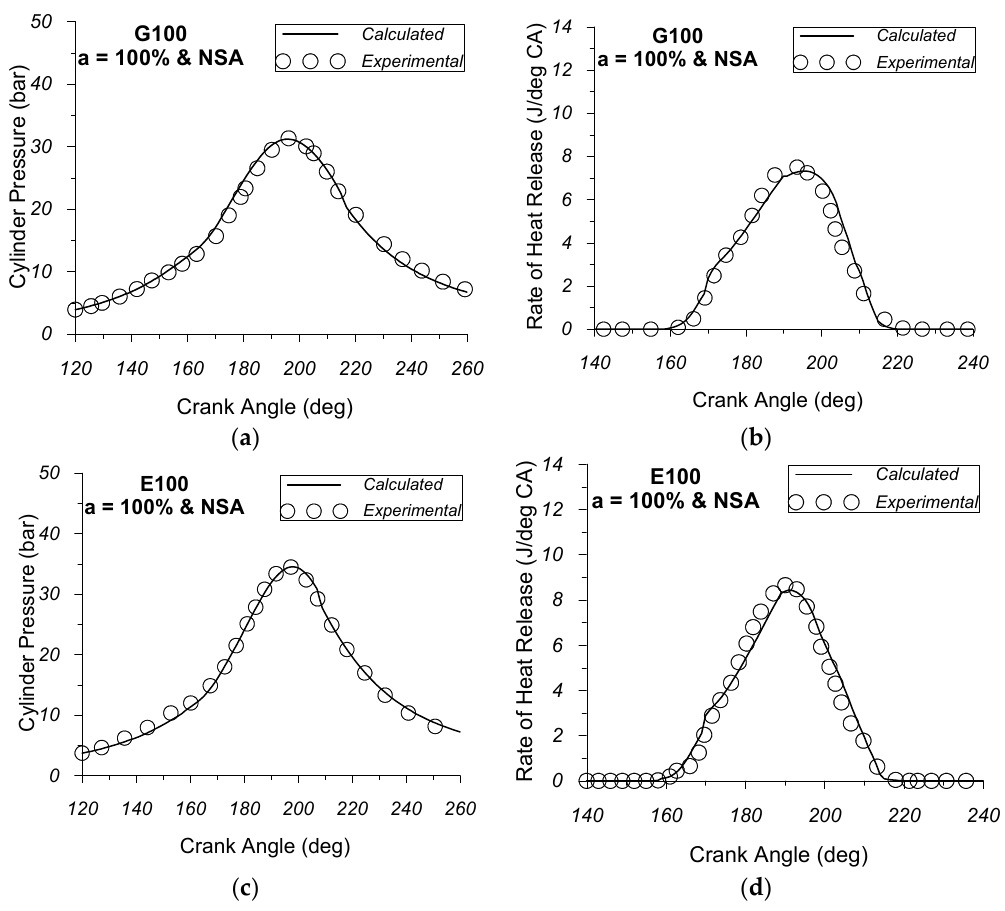
Figure 1. Comparison between experimental and computed cylinder pressure and rate of heat release traces of the “DatsuL200” engine, running at 100% of full engine load and 2400 rpm engine speed with normal spark timing, operating under G100 ( a , b ); or E100 ( c , d ); fuel modes.